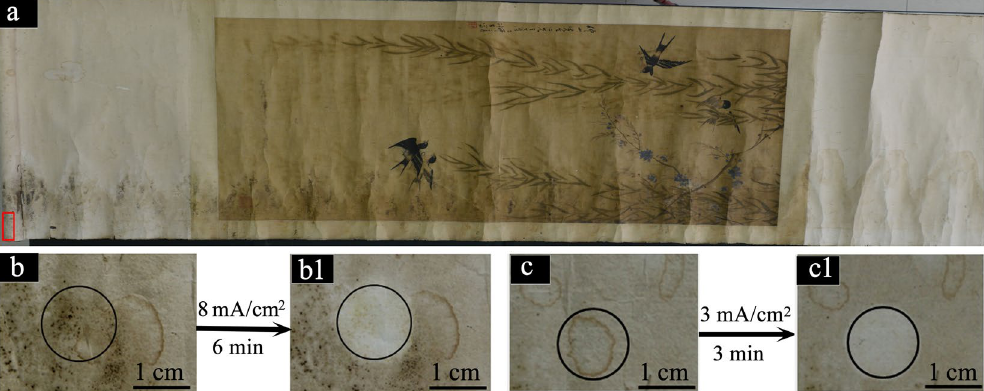
Figure 6. Performance of HPEC for eliminating various stains (mildew, foxing and tideline) on a real artwork. ( a ) A Chinese painting created by Xu Shi (Qing Dynasty, ~1850); ( b ) an original piece with mildew stains collected from the painting (red box region); (b1) the piece with mildew stains after treatment by using HPEC at 8.0 mA/cm 2 within 6 min; ( c ) an original piece with foxing stains collected from the painting (red box region); (c1) the piece with foxing stains after treatment by using HPEC at 3.0 mA/cm 2 within 3